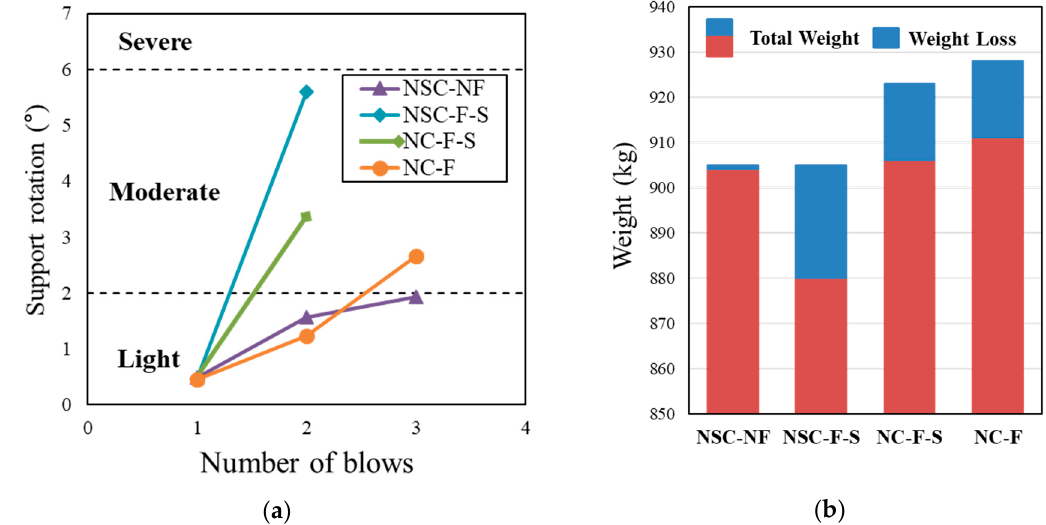
Figure 8. Support rotation and weight loss by impact loading: ( a ) Support rotation; ( b ) Weight loss.